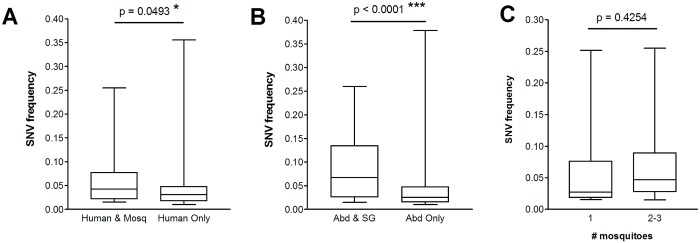
Frequencies of maintained SNVs compared to SNVs lost during horizontal transmission.
(A) Frequencies of DENV2 SNVs maintained from human to mosquito, versus those present only in the human. (B) Frequencies of DENV2 SNVs maintained from mosquito abdomen to mosquito salivary gland, versus those present only in the abdomen. (C) Frequencies of SNVs maintained in one mosquito per human-mosquito group, versus those maintained in more than 1 mosquito per group. Boxplots indicate medians and 25th and 75th percentiles; whiskers indicate minimum and maximum values. *, p < 0.05; ***, p < 0.0001; Mann-Whitney test.